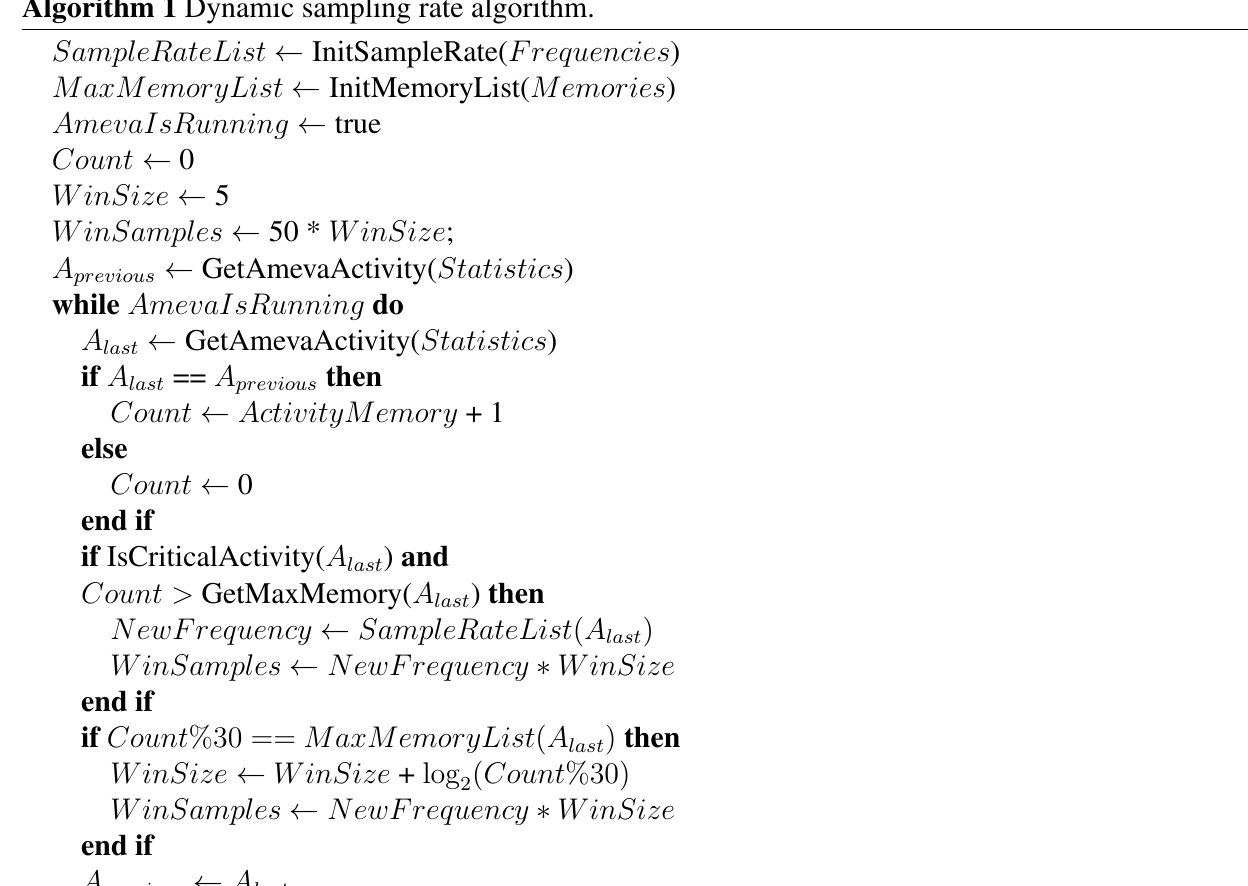
Algorithm 1 Dynamic sampling rate